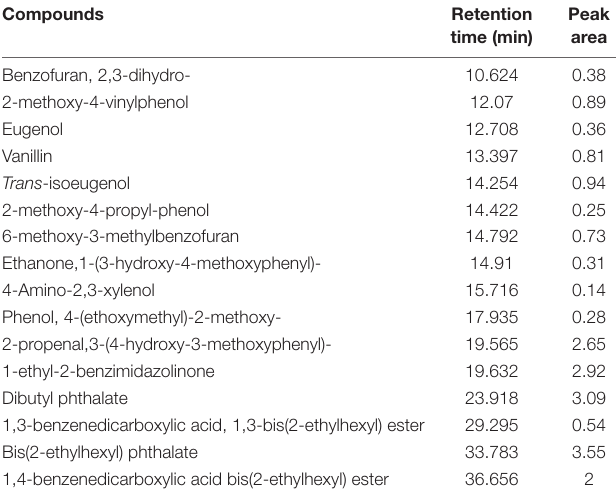
TABLE 2 | Identification of the aromatic compounds in bio-oil pyrolyzed from masson pine via py-GC/MS.